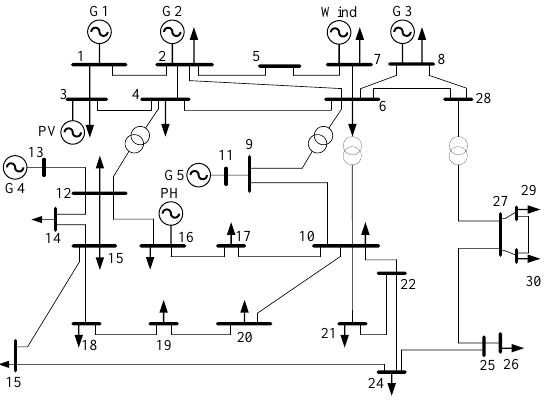
Figure 4. Modified IEEE 30-bus system. Table 1. Parameters of thermal units.